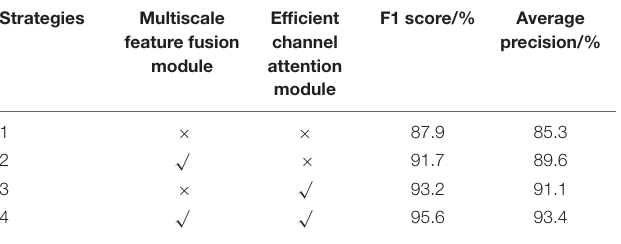
TABLE 4 | Detection effects of ablation experiments.